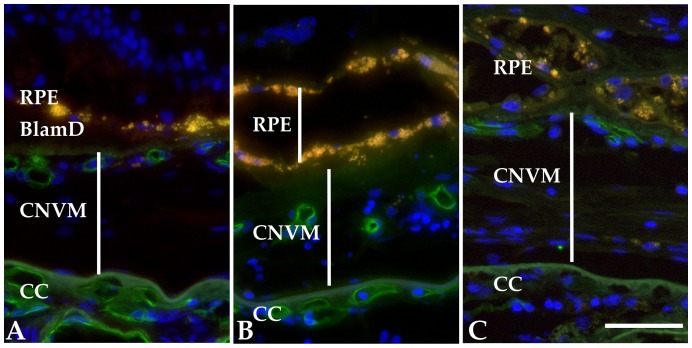
Expression of CD34 in pathologic blood vessels in choroidal neovascular membranes (CNVMs) from 3 donors with neovascular AMD.Abnormal vessels within the CNVMs were invariably strongly positive (arrows). RPE, dystrophic retinal pigment epithelium; BlamD, layer of basal laminar deposit; CC, choriocapillaris. Scalebar in C, 50 µm.